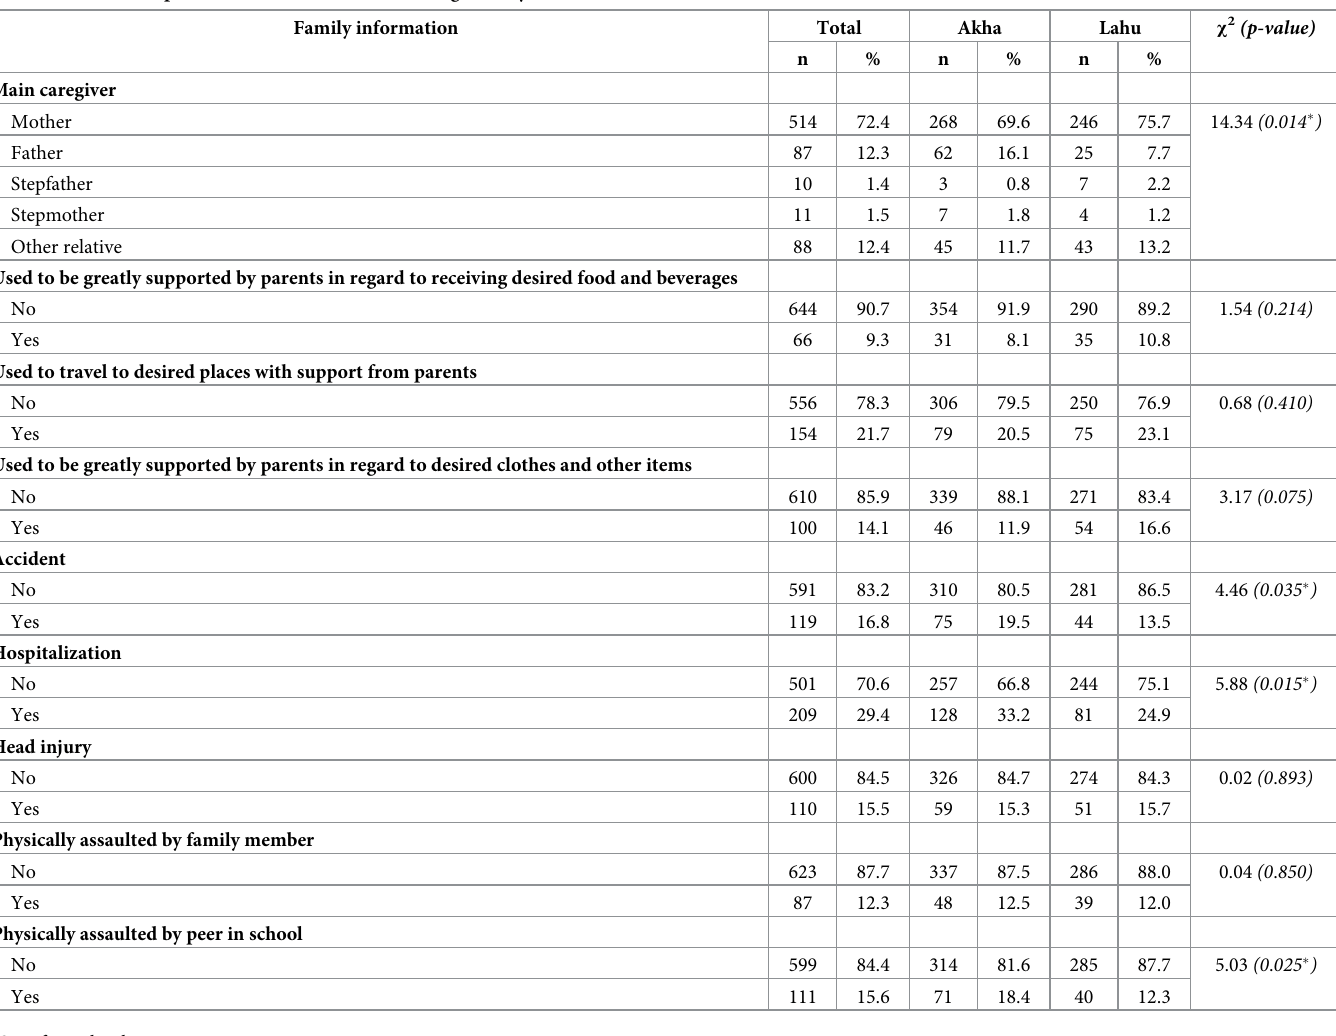
Table 3. Potential exposures relevant to MA use while aged 0–5